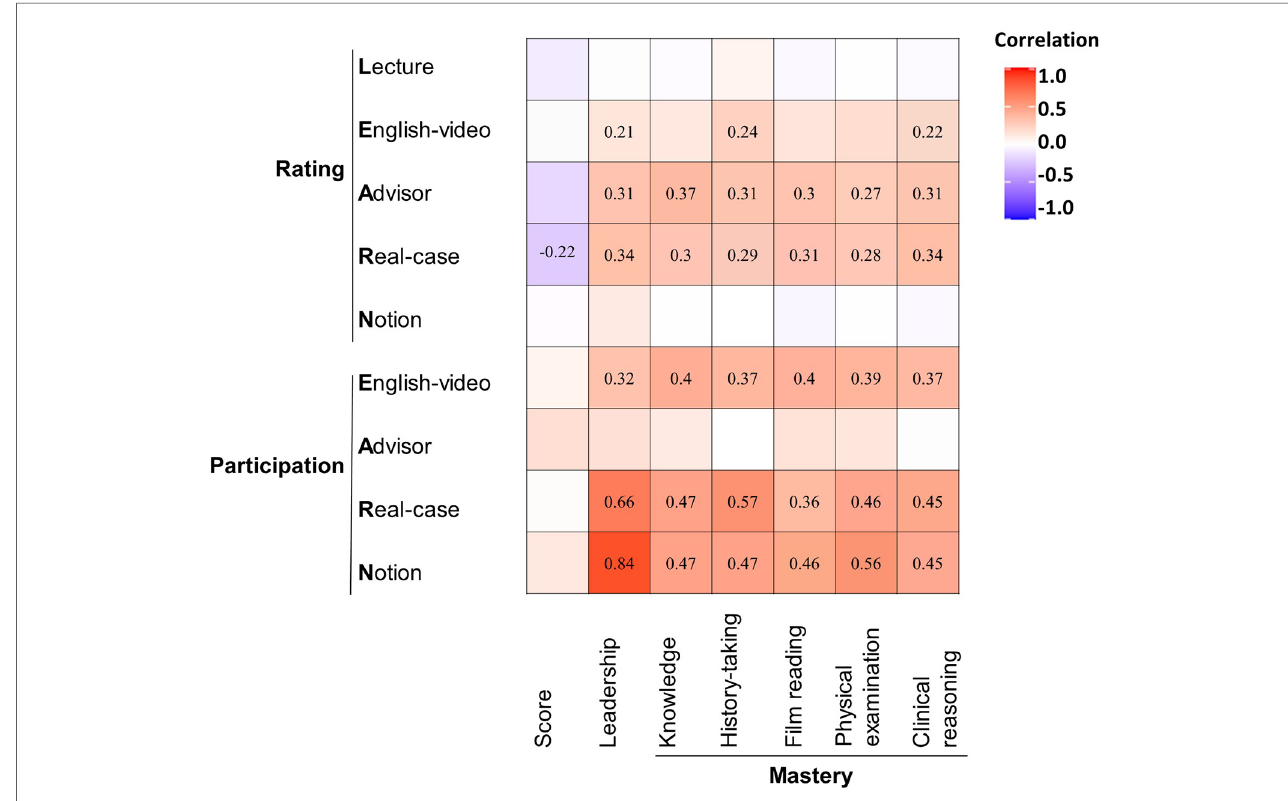
FIGURE 3 Corheatmap of variables involved in LEARN